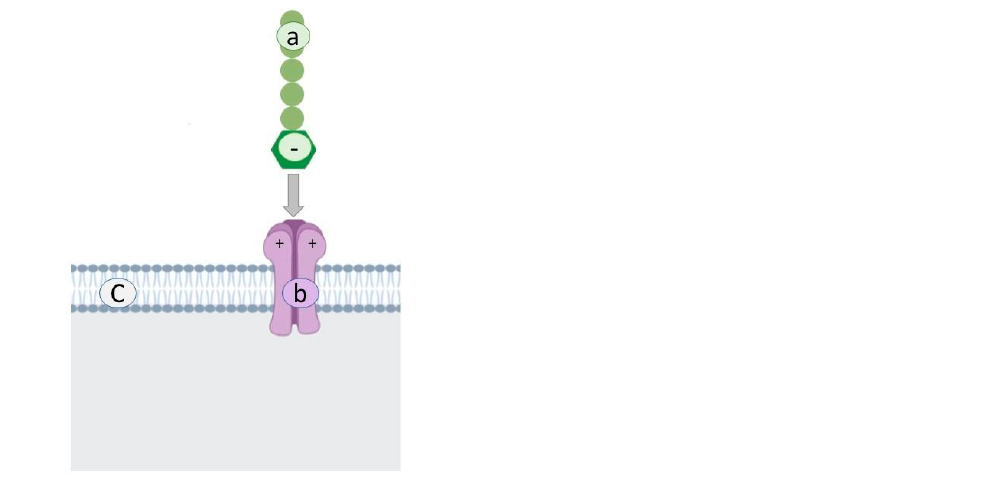
Figure 2. Mechanism of interaction of sulphate polysaccharides. Sulphate polysaccharide ( a ), thanks to the negative charge of the sulfonate group, interacts with the positively charged domains ( b ) of the viral glycoprotein envelope ( c ) and creates a non-reversible complex.